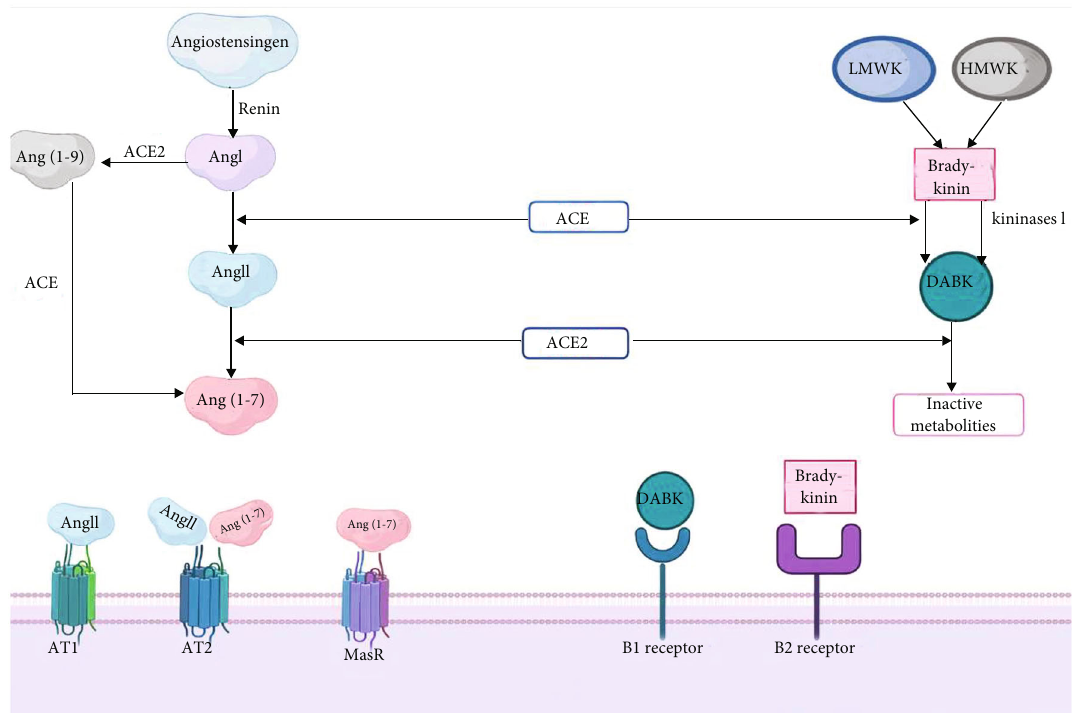
Figure 2: Role of ACE2 and ACE in the renin angiotensin system and kinin